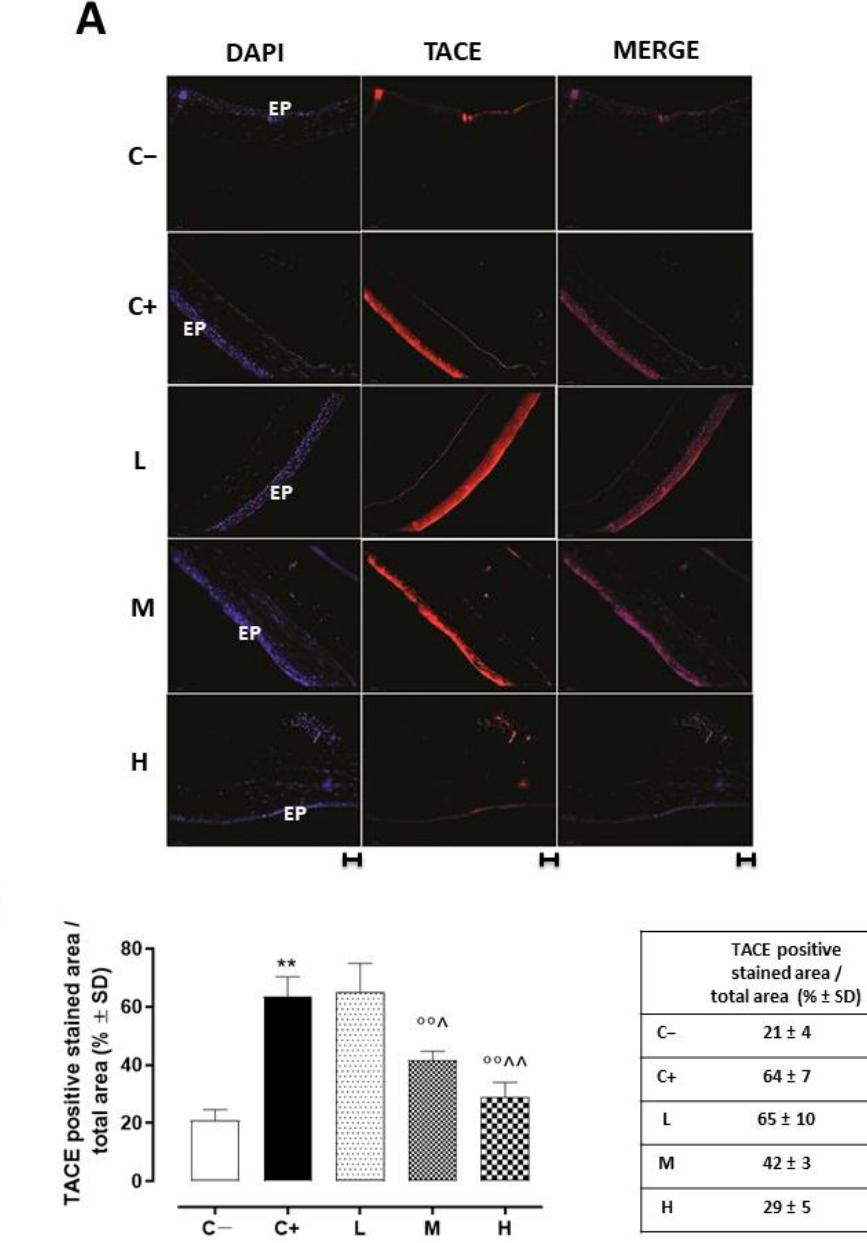
Figure 3. ( A ) Representative immunofluorescence images of TACE staining (red) and ( B ) relative quantization, expressed as percentages of TACE positive cells (red)/total cells counted (blue) in the TSP-1 KO mice euthanized at 6 weeks of age as a negative control for SS-associated dry eye (C − ); TSP-1 KO mice euthanized at 12 weeks of age as a positive control for SS-associated dry eye (C+); and TSP-1 KO mice supplied with low (L), medium (M), and high (H) doses of vitamin D3 (1000, 8000, and 20,000 IU/kg/week, respectively) from week 6 to week 12 of age. N = 7 corneas per group; EP: corneal epithelium; scale bar 20 µ m; magnification 40 × . ** p < 0.01 vs. C − ; ◦◦ p < 0.01 vs. C+; ˆ p < 0.05 and ˆˆ p < 0.01 vs.